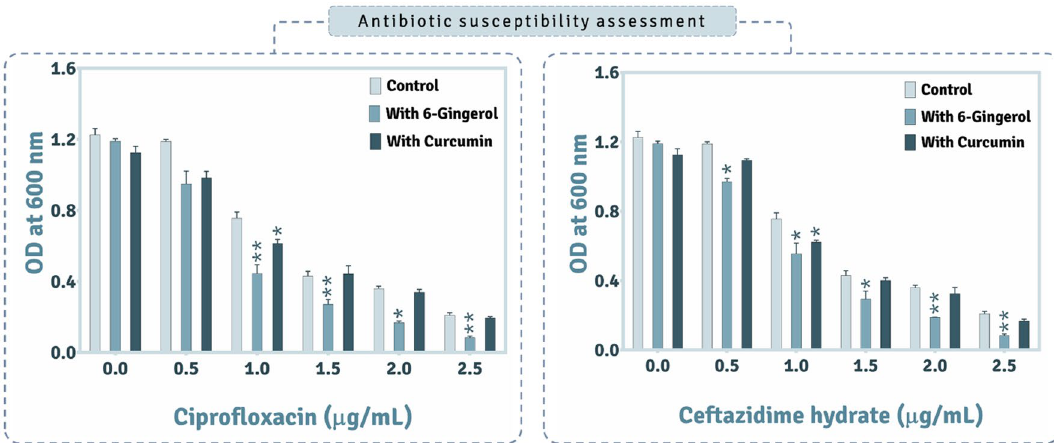
Figure 11. Assessing the impact of 6-Gingeol and Curcumin on modulation in antibiotic susceptibility of P. aeruginosa AM26 against ciprofloxacin and ceftazidime hydrate (n = 4, error bars, standard error of mean, Student T-test P value (control vs. test) represents the following ‘**’ for P < 0.00001, and ‘*’ for P < 0.0005 versus the control.